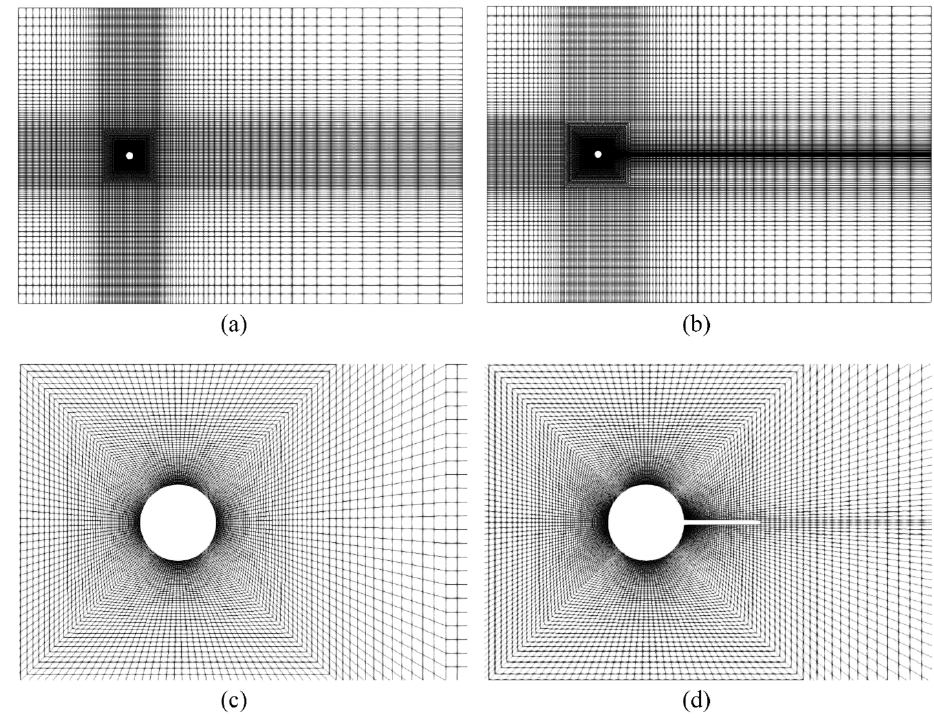
Figure 3. Computational mesh used to discretize the computational domain. Mesh partitioning of whole domain and local mesh refinement close to the surface of the bare circular cylinder ( a , c ) and the cylinder-plate assembly ( b , d